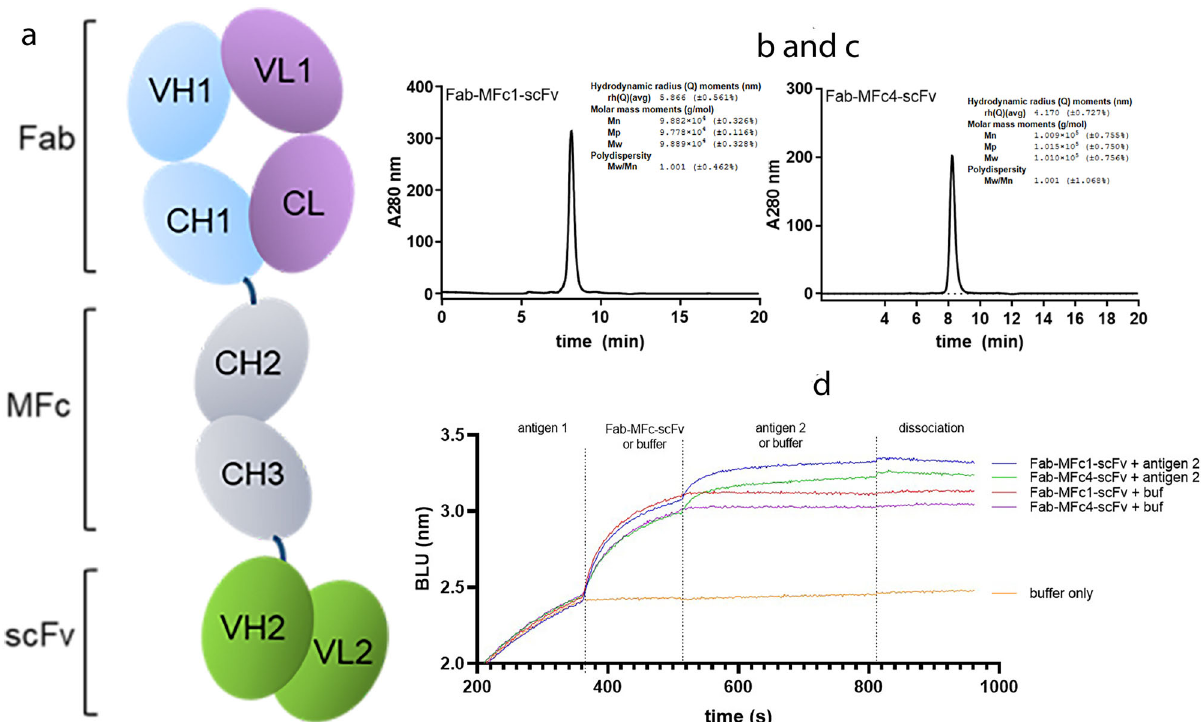
Fig. 5 Generation of monomeric Fc bispeci fi c antibodies. a Cartoon of a monomeric Fc-based monovalent bispeci fi c antibody. b , c SEC-MALS analysis of Fab-MFc1-scFv and Fab-MFc4-scFv showing the measured molecular weight of approximately 100 kDa, with a polydispersity of 1.001. d Concurrent binding analysis using biolayer interferometry demonstrated expected binding activity from both the Fab and scFv moieties to recombinant antigens.